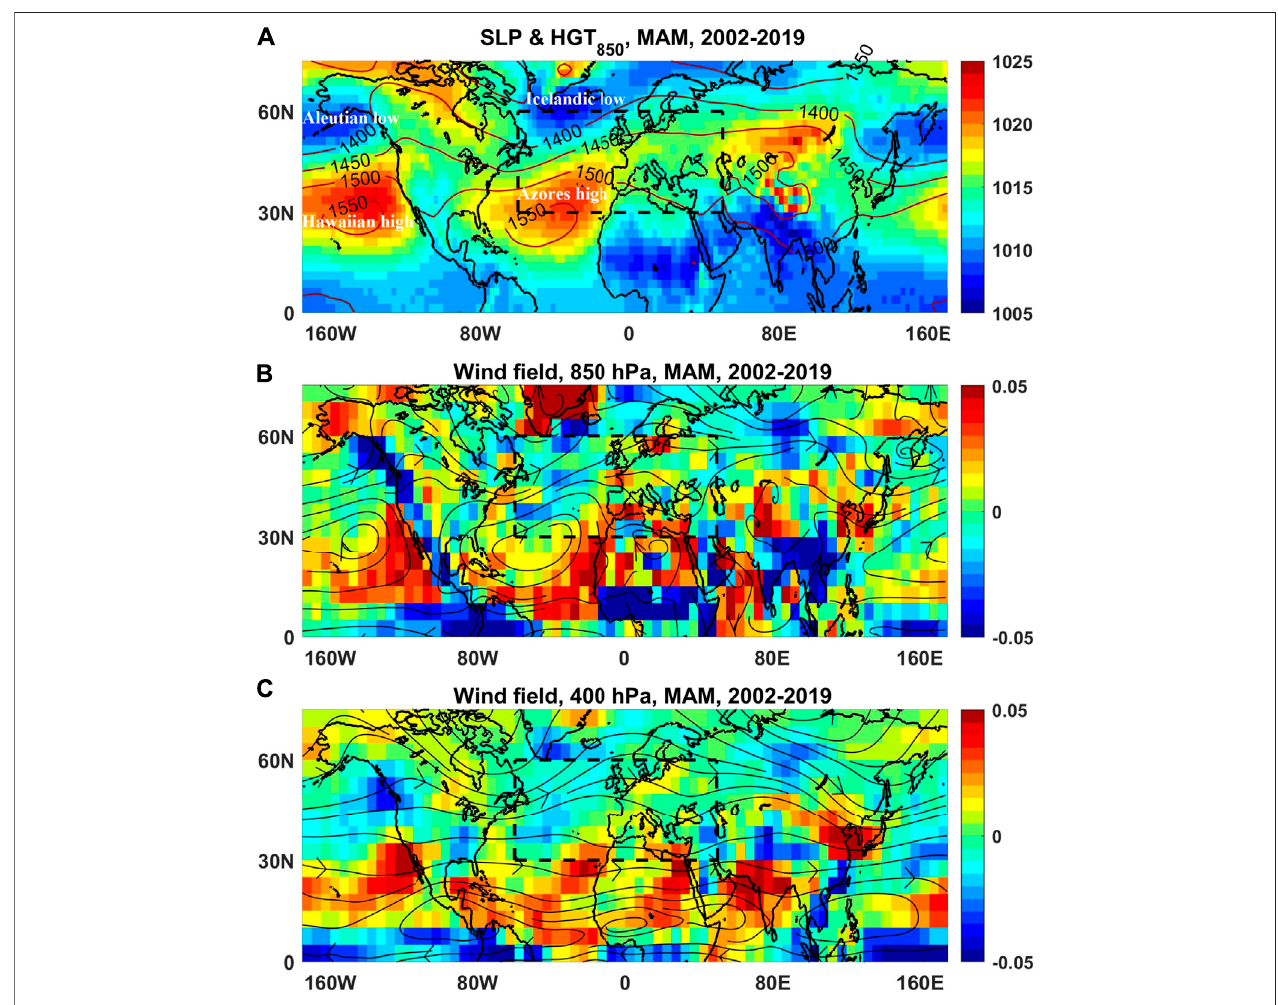
FIGURE 7 | (A) Mean MAM sea level pressure (SLP, in color, unit: hPa) and geopotential height at 850 hPa (HGT, in contour, unit: m) over 2002 – 2019. (B) Horizontal wind fi elds (streamlines) averaged over 2002 – 2019 in MAM at 850 hPa. Overlaid is the corresponding vertical velocity (in color, Pa s − 1 ). (C) The same as (B) , but at 400 hPa. Note the upward velocity is negative (in